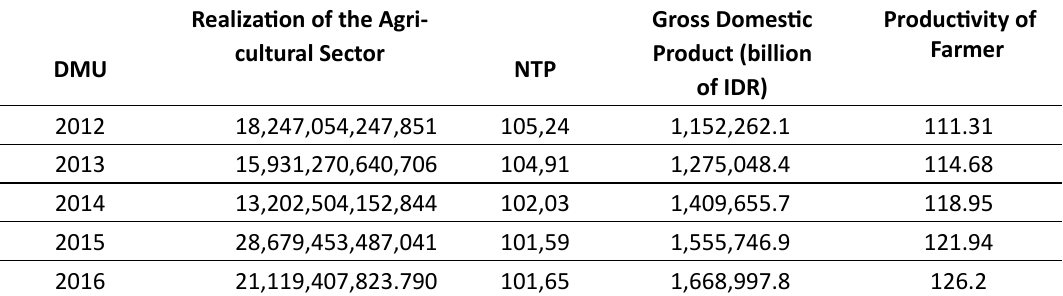
Table 1: Input and Output of